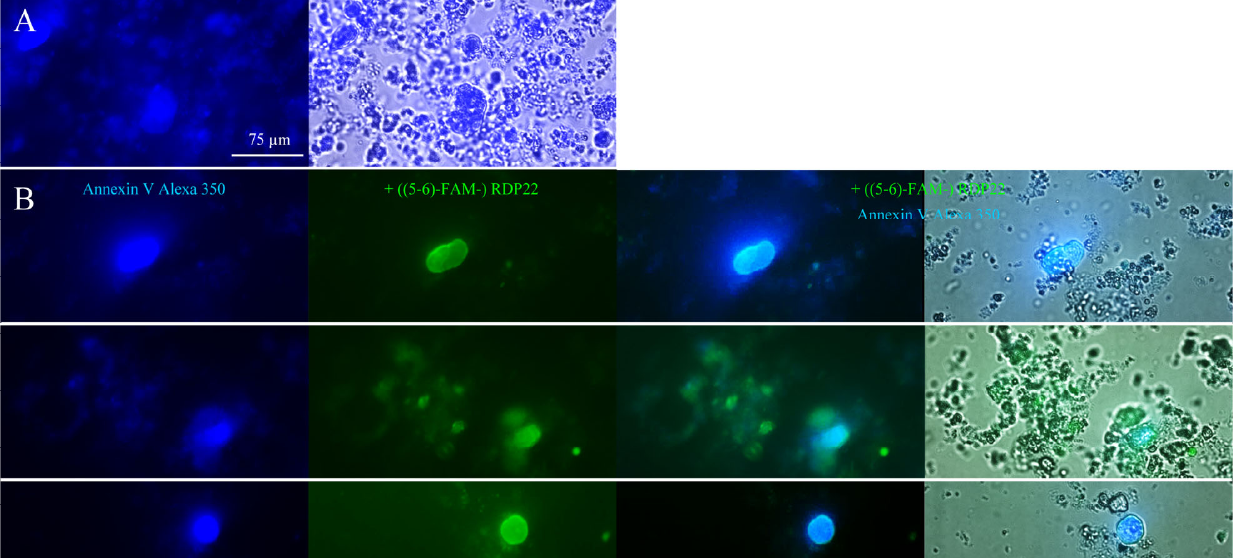
Figure 2. PS ‐ peptide interaction is shown with liposomes (1–2 mM) composed of DPPS that were incubated with Annexin V Alexa Fluor 350 conjugate (blue) alone ( A ) to visualize PS (fluorescence, overlay fluorescence with bright field) or additionally with ( B ) 10 μ M fluorescently labeled ((5 ‐ 6) ‐ FAM ‐ ) RDP22 (green) fluorescence, overlays of fluorescence or with bright field). Microscopy pictures shown represent the outcome of three independent experiments.